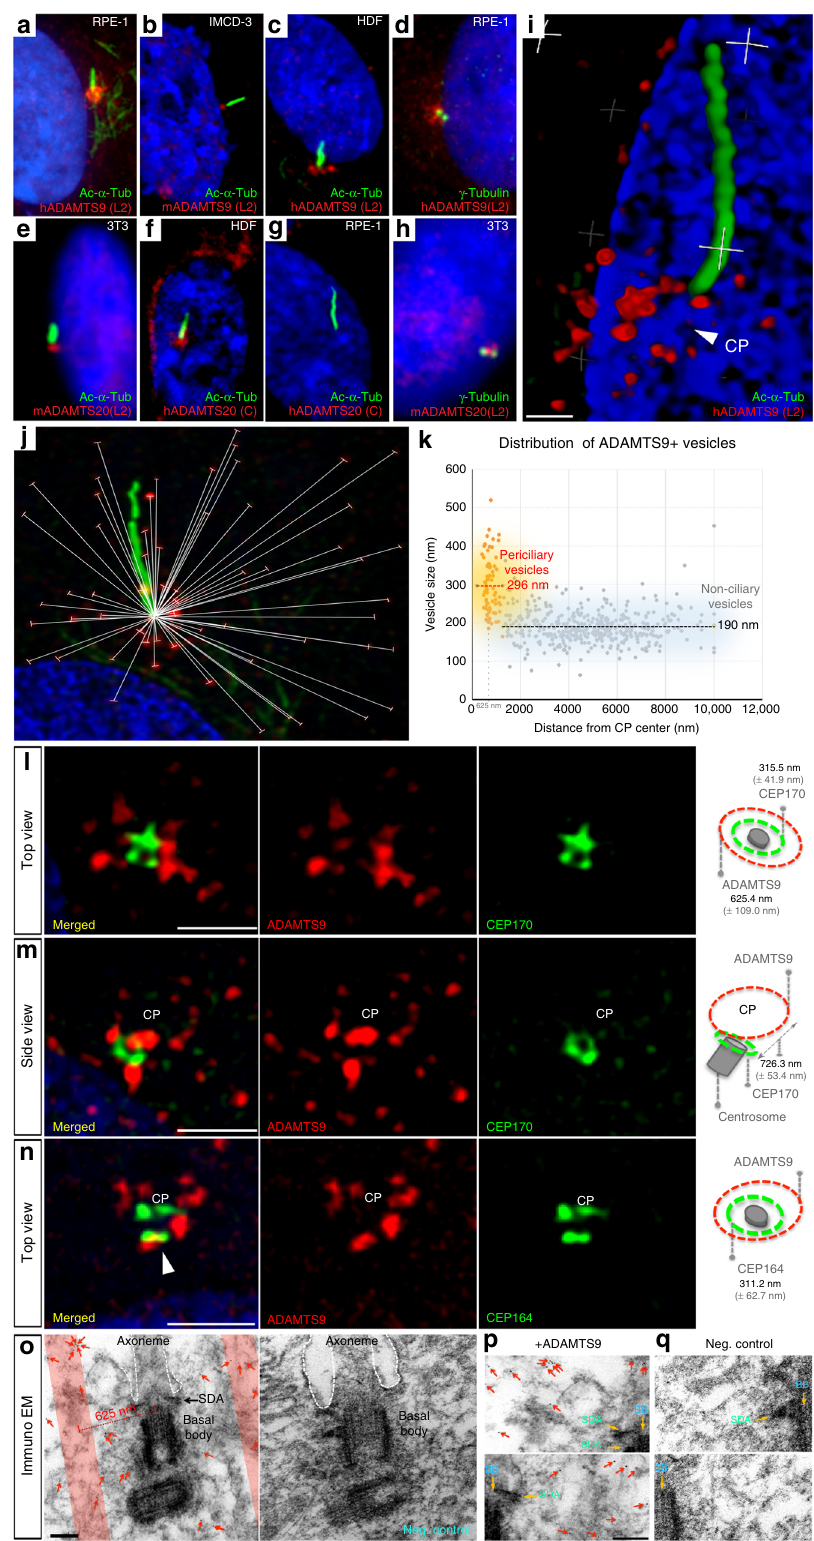
cilium length. Taken together, the results suggested that secreted ADAMTS9 was recycled, localizing to a subpopulation of late recycling endocytic vesicles targeted to the primary cilium in a highly dynamic process necessary for ciliogenesis.